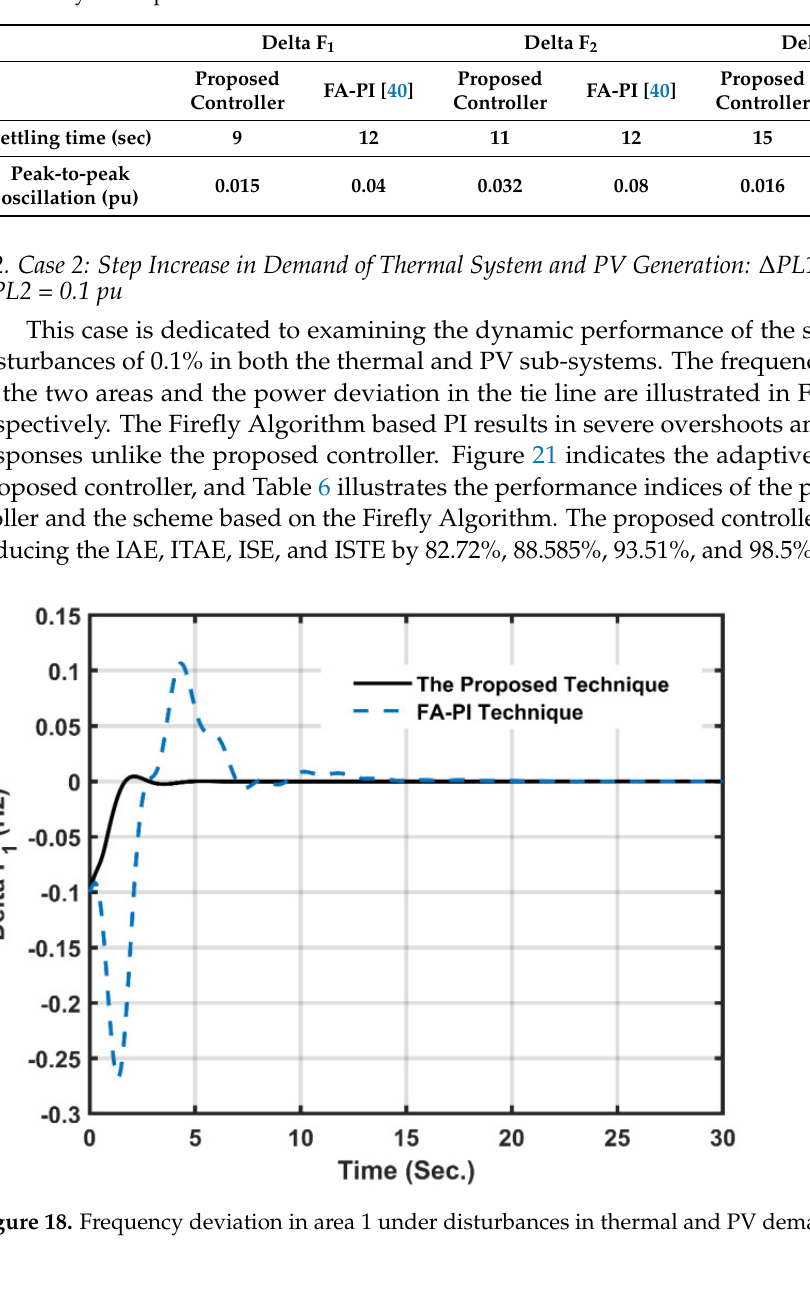
Figure 19. Frequency deviation in area 2 under disturbances in thermal and PV demands.